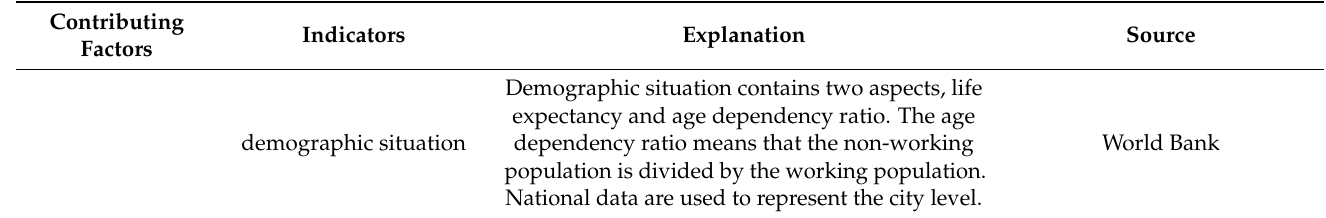
Table 4. Contributing